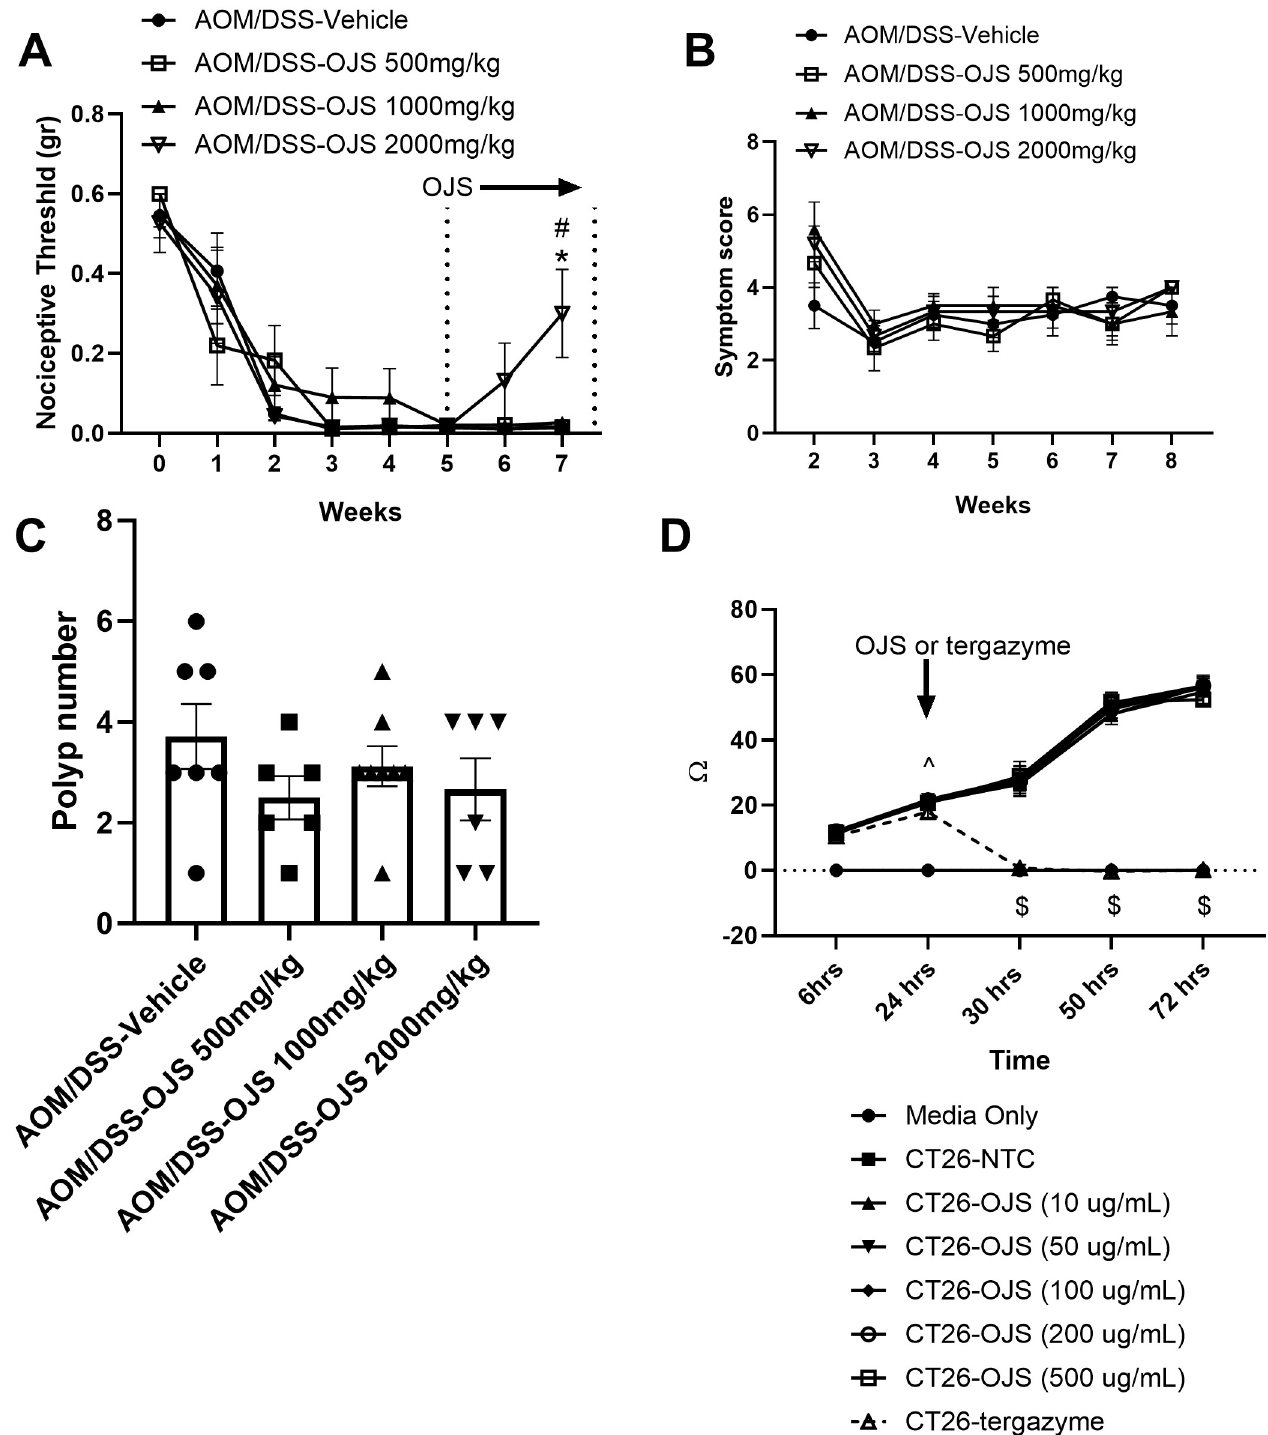
Fig 2. OJS (2000 mg/kg) mitigates referred somatic hyperalgesia in colitis-induced colorectal cancer without impacting tumor burden. (A) Mechanical nociceptive threshold to von Frey filament (0.008, 0.02, 0.04, 0.07, 0.16, 0.40, and 0.60 gr). (B) Disease activity was calculated using score-based symptoms including body weight loss, fecal consistency, and blood in the stool. (C) Polyp count. Number of mice per group as indicated: AOM/DSS-Vehicle, n = 8; AOM/DSS-OJS 500 mg/kg, n = 7; AOM/DSS-OJS 1000 mg/kg, n = 8; and AOM/DSS-OJS 2000 mg/kg, n = 6. � Indicates statistical significance (p < 0.05) for AOM/DSS-Vehicle versus AOM/DSS OJS 2000 mg/kg; # indicates statistical significance (p < 0.05) for AOM/DSS-OJS 500 mg/kg versus AOM/DSS-OJS 2000